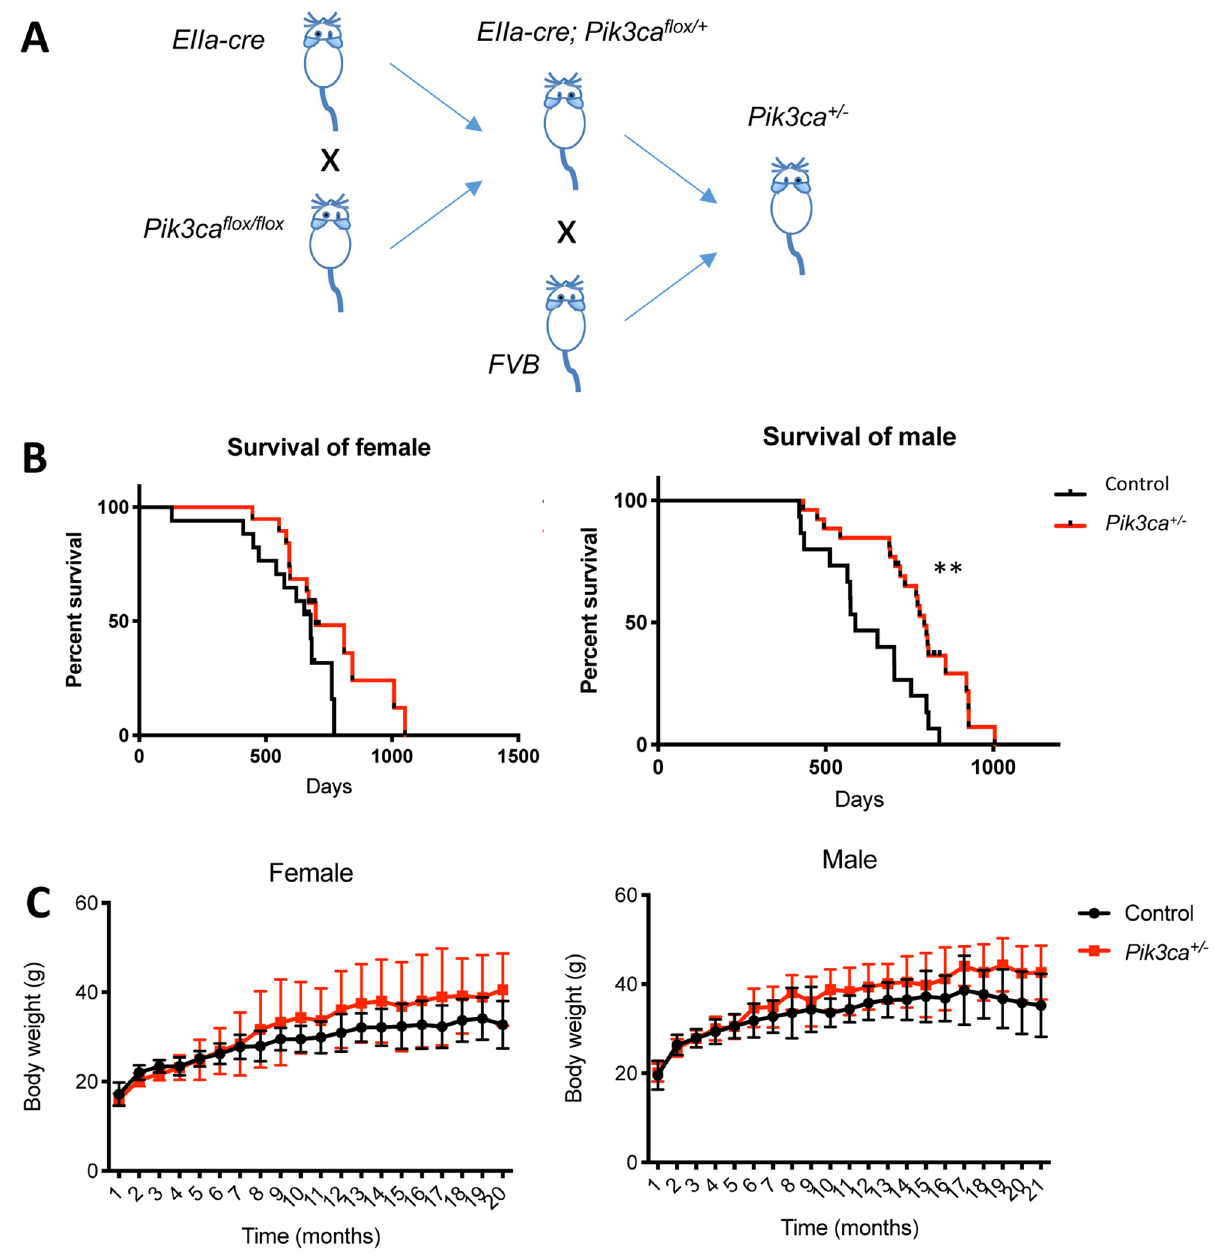
Figure 1. Pik3ca + /− mice live longer. ( A ) Schematic flow chart for generating Pik3ca + /− mice. ( B ) Kaplan–Meier survival curves of Pik3ca + /− mice (red line) and control mice (black line) (left panel: female; right panel: male). ** P < 0.01 ( C ) Body weight of mice at different ages. Mice of both genders (left panel: female; right panel: male) were monitored monthly. Data represents mean ± SD ( n = 5–16 at each time